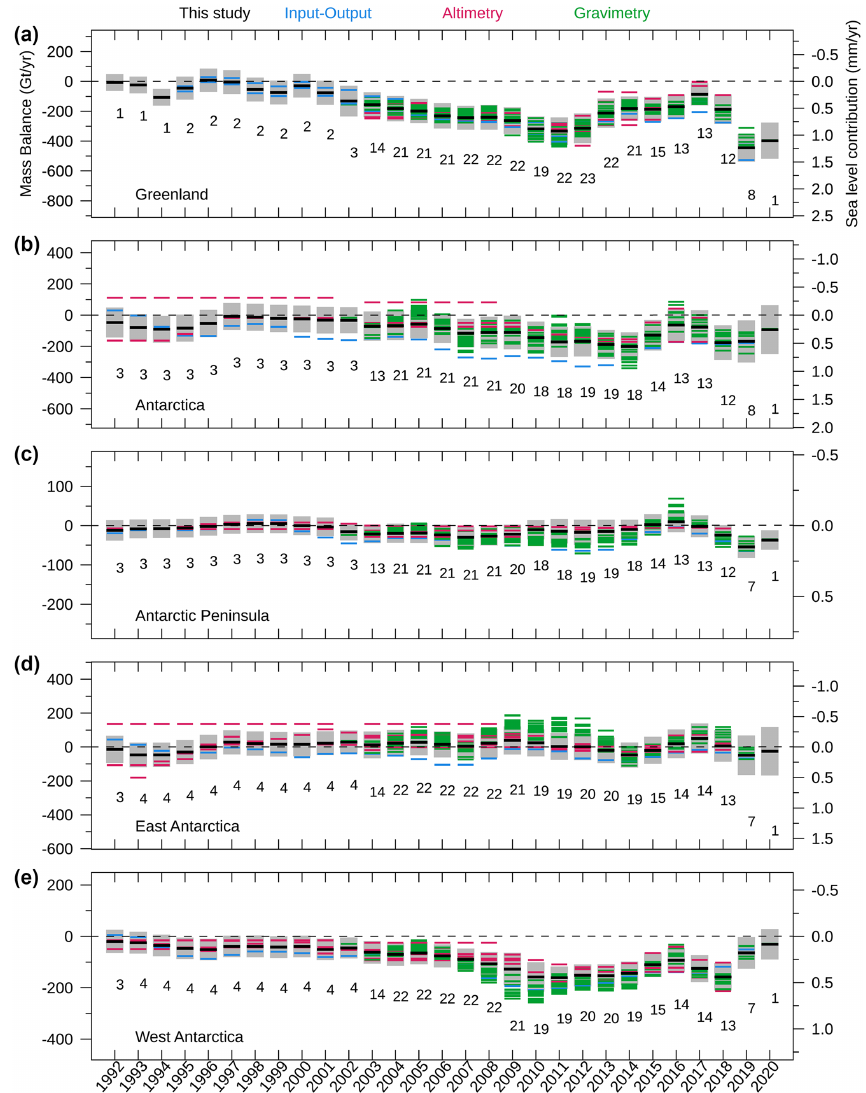
Figure 2. Annual rates of mass change in (a) GrIS, (b) AIS, (c) APIS, (d) EAIS, and (e) WAIS from the altimetry, gravimetry, and input– output estimates included in this study (coloured bars) and the reconciled estimate produced from combining those estimates (thick black bars). The grey shading shows the uncertainty in our final reconciled estimate, which is calculated following the procedure described in Sect. 3 (iii). The number of individual mass balance estimates collated at each epoch is shown below each